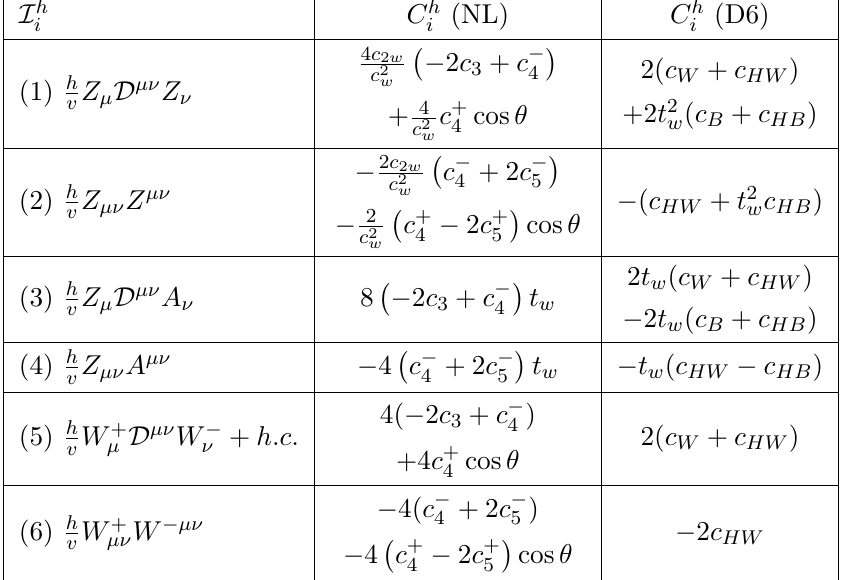
for the non-linearity case (NL) and the purely i (cid:22)(cid:23) denotes @ (cid:22) @ (cid:23) (cid:17) (cid:22)(cid:23) @ 2 D (cid:0)